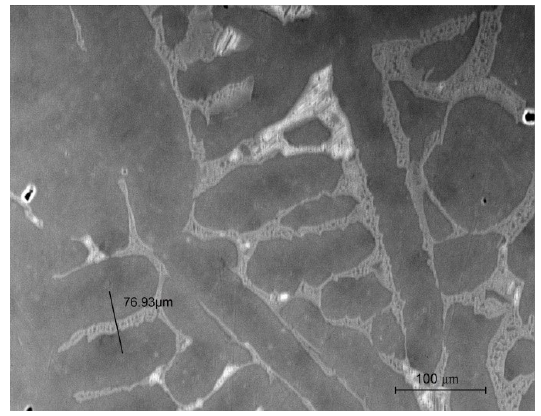
Figure 1. Typical track adopted for measurements of solute microsegregation of the Cu − 20 wt.% Sn